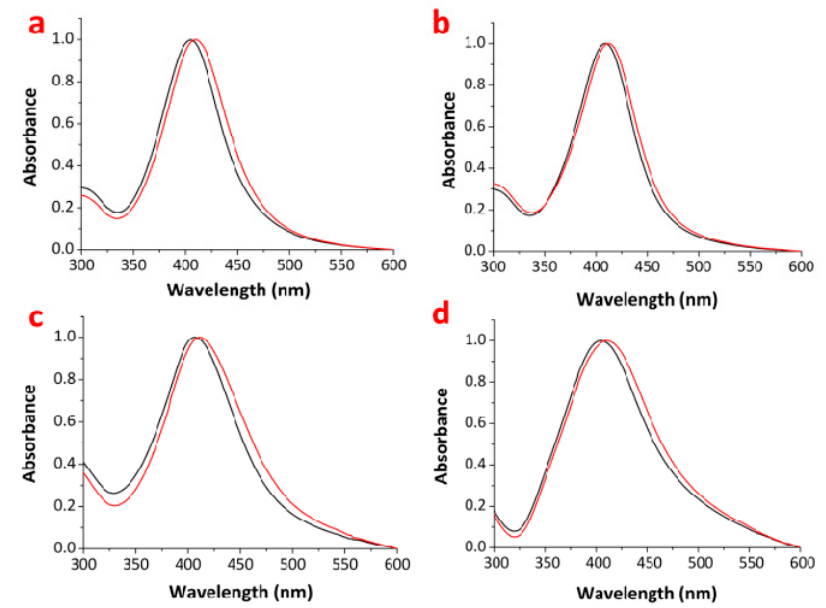
Figure 3. UV-vis spectra of the nanocomposites ( a ) polymer A , ( b ) polymer B , ( c ) polymer C , and ( d ) polymer D with the ratio ( 3 ) at RT (black) and 37 °C (red).